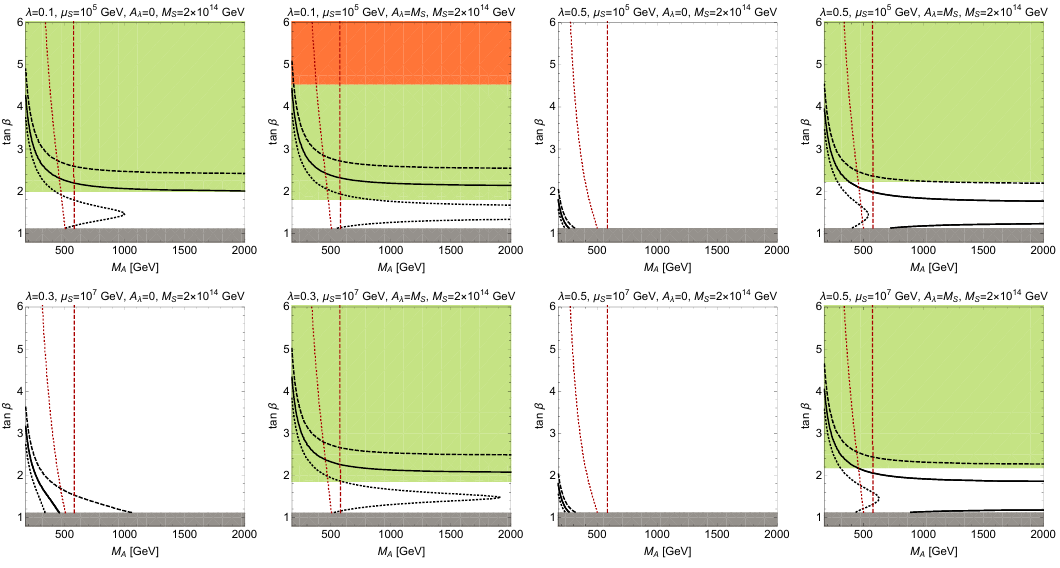
Figure 8 . Same as (cid:12)gures 4, 5 but for M